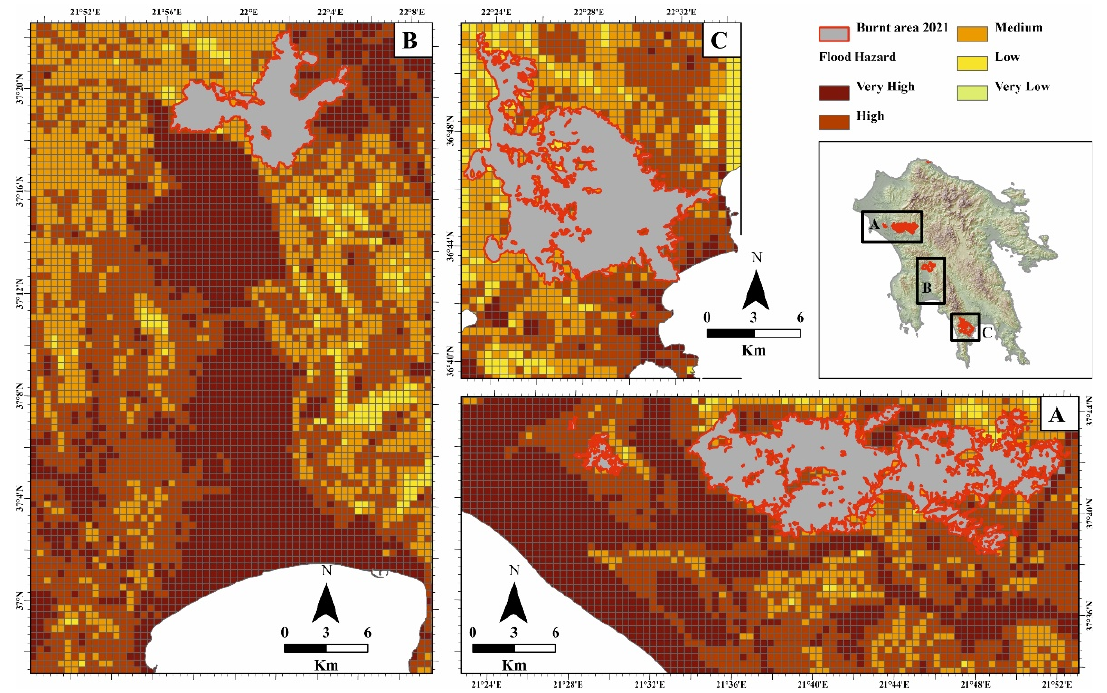
Figure 13. Flash flood hazard in the fire-affected area of Peloponnese using a Boolean logic-based model: ( A ) Ancient Olympia, ( B ) Diavolitsi, and ( C ) East Mani.